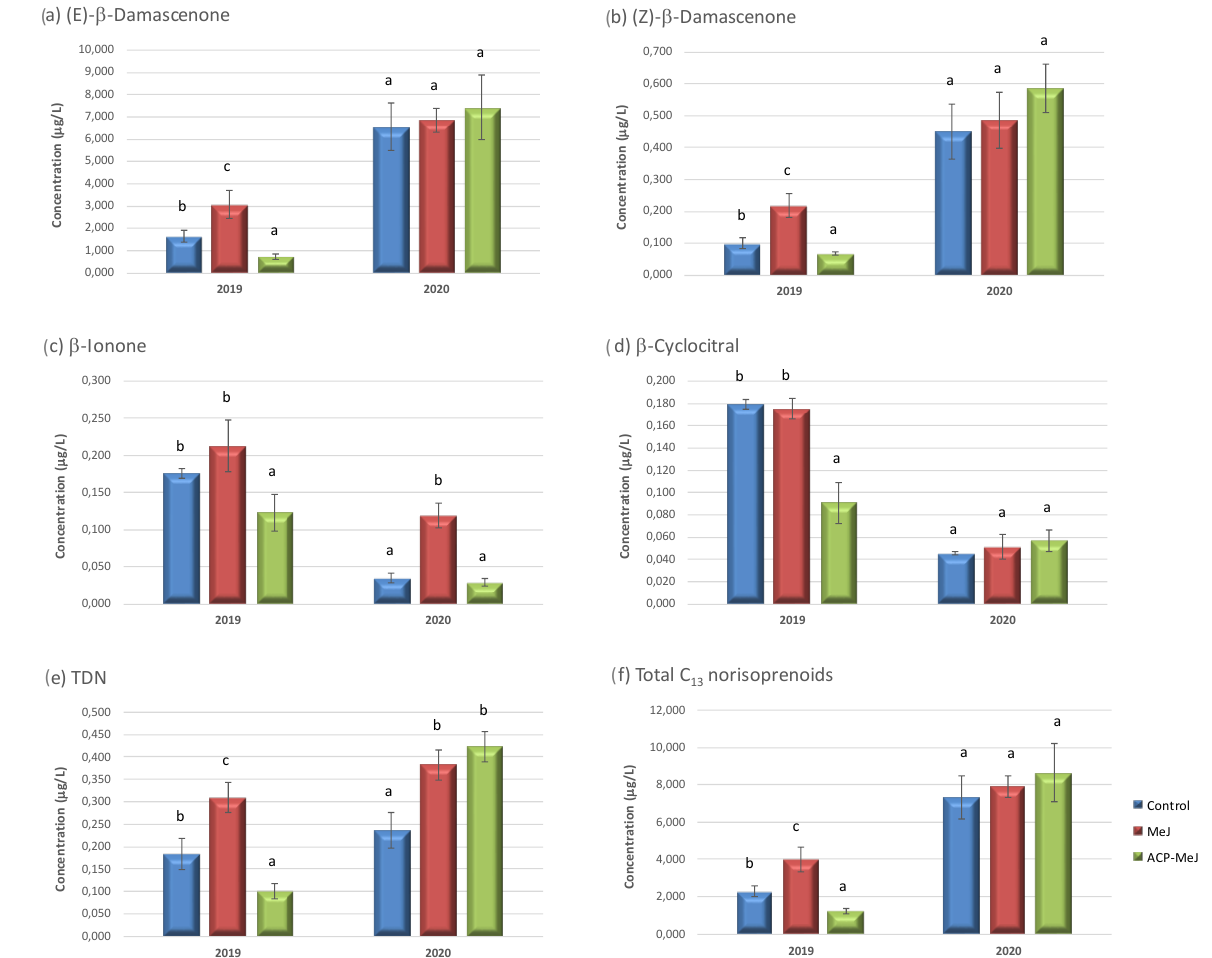
Figure 2. C 13 norisoprenoids concentration ( µ g/L) in grapes from control, methyl jasmonate (MeJ) and nanoparticles doped with MeJ (ACP-MeJ) foliar treatments, in 2019 and 2020 seasons. All parameters listed with their standard deviation ( n = 3). For each season and compound, different letters indicate significant differences between samples ( p ≤ 0.05). TDN: 1,1,6-trimethyl-1,2-dihydronaphthalene.